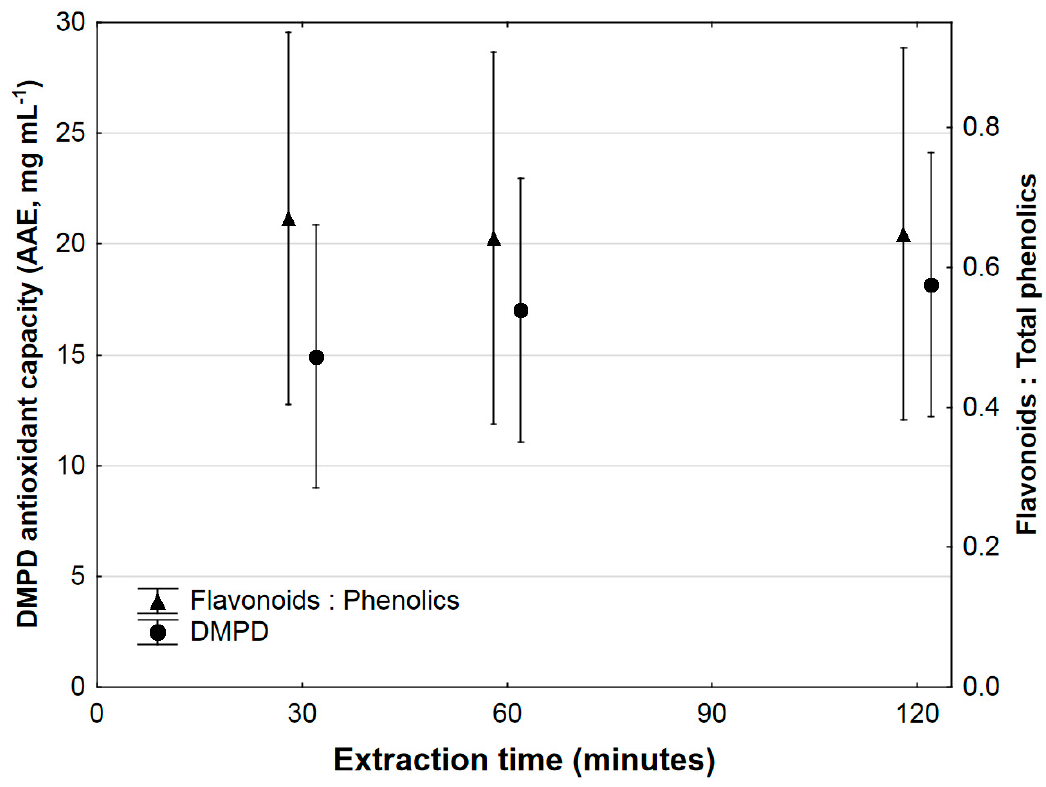
Figure 3. N , N -Dimethyl- p -phenylenediamine dihydrochloride (DMPD) antioxidant capacity and ratio of total flavonoids to total phenolics, for 70% ethanol extracts of Ximenia caffra . Data are represented as mean ± 95% confidence intervals.